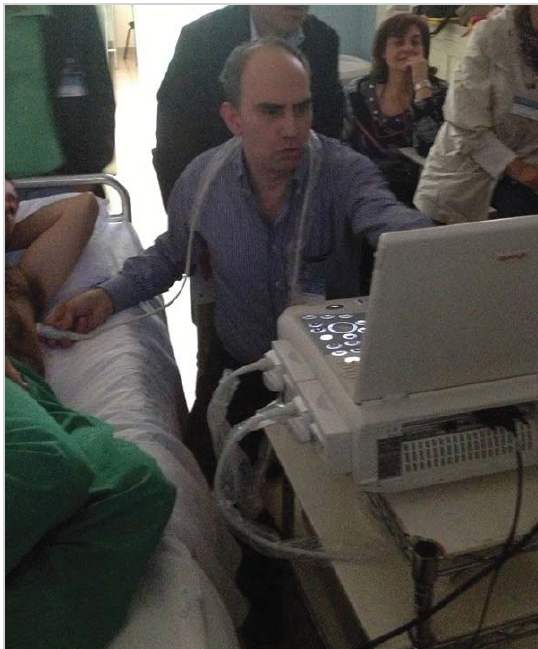
Figure 3. Dr. L. Di Lullo during an echocardiographic practical